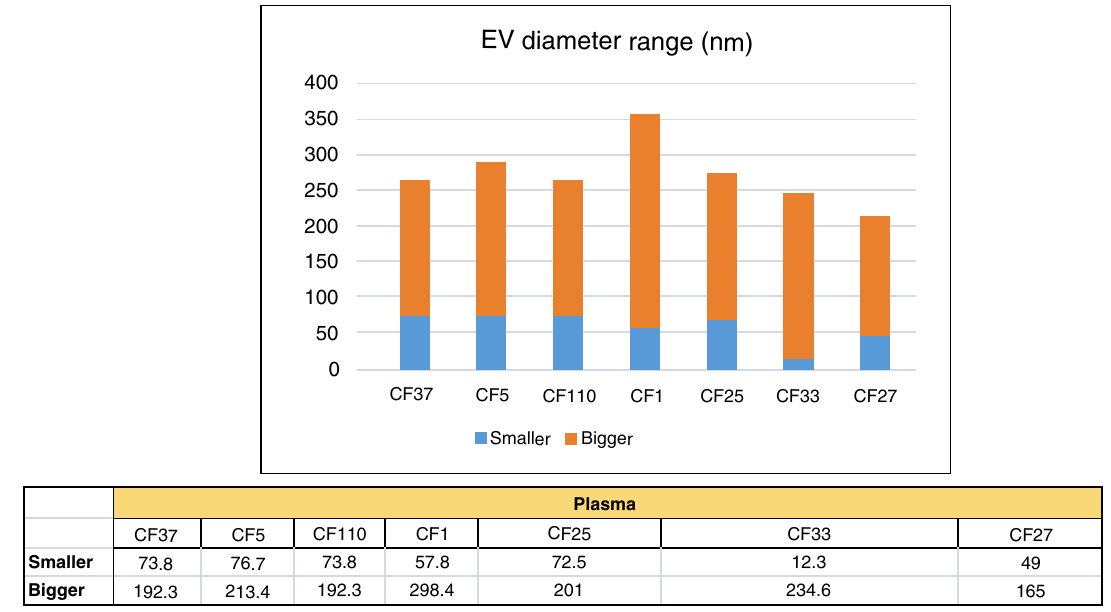
Figure 1. Nanosight (NTA) analysis for samples C7, CF37, CF5, CF110, CF1, CF25, CF27 and